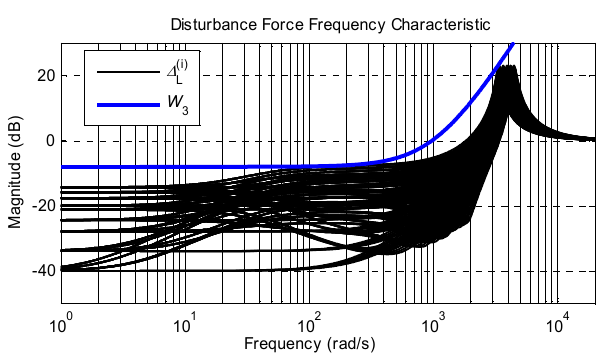
Figure 11. The defined system uncertainties and the 3 ( ) W s .